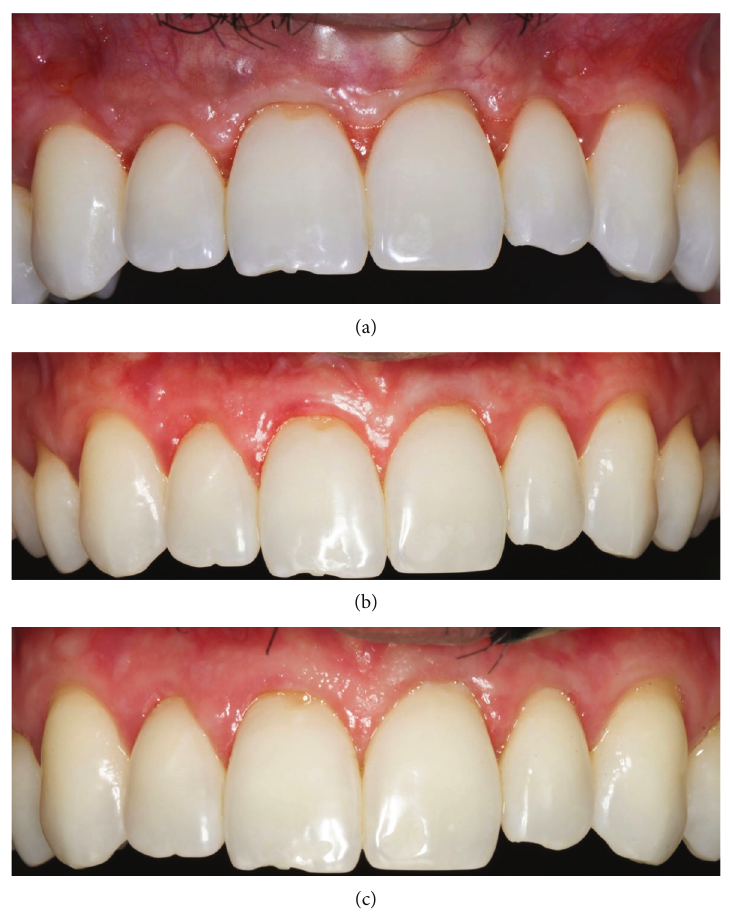
Figure 2: Postoperative follow-up. (a) Clinical view on 2-month follow-up, (b) clinical observation on 9-month follow-up, (c) clinical view on 12-month